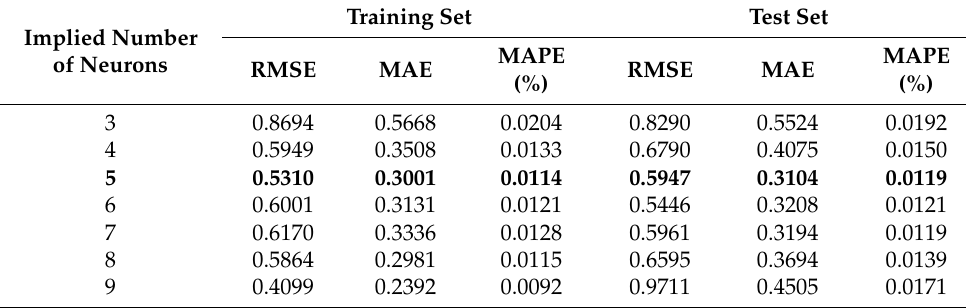
Table 8. BP neural network machine learning training results.